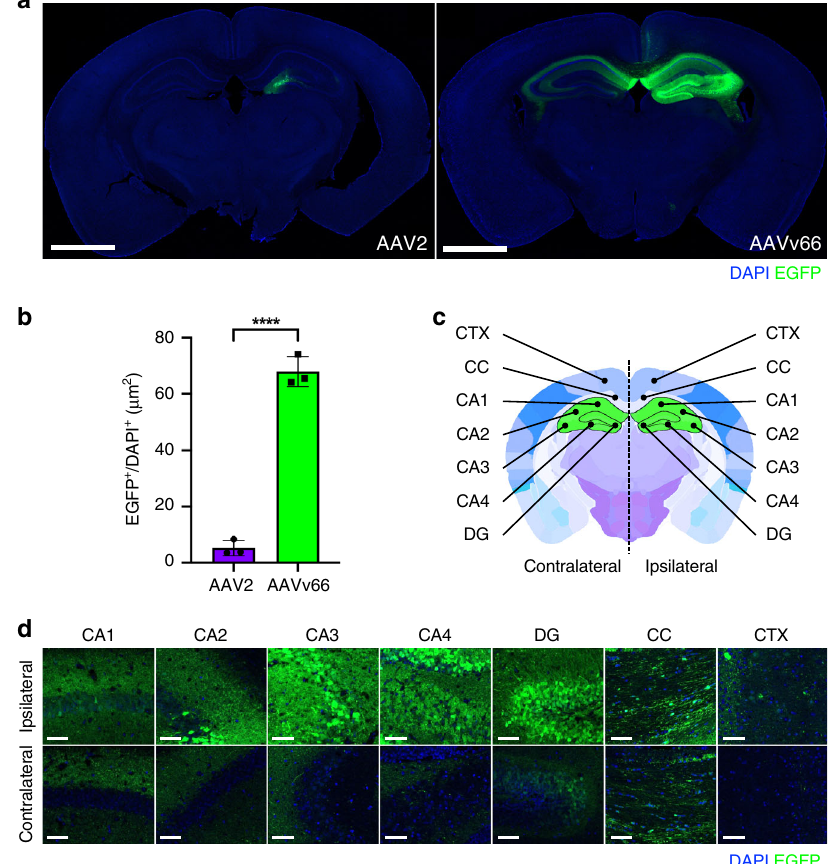
Fig. 2 Transduction spread of rAAV2 and rAAVv66 following intrahippocampal injection. a Representative native EGFP (green) expression following rAAV2-CB6-PI- EGFP or rAAVv66-CB6-PI- EGFP injection via unilateral intrahippocampal administration. Scale bars = 700 μ m. b Quanti fi cation of EGFP- positive surface normalized to DAPI-positive surface from panel a data. Data are presented as the mean ± SD; n = 3 animals/group from one experiment. **** P < 0.0001, two-tailed Student ’ s t test. c Coronal brain schematic depicting sub-anatomical regions of interest in both contralateral and ipsilateral hemispheres (adapted from Allen Mouse Brain Atlas). Cornu ammonis (CA1 – CA4), dentate gyrus (DG), corpus callosum (CC), and cortex (CTX). d Representative high-magni fi cation images of rAAVv66 transduced sub-anatomical regions from n = 3 animals from one experiment. Scale bars = 50 μ